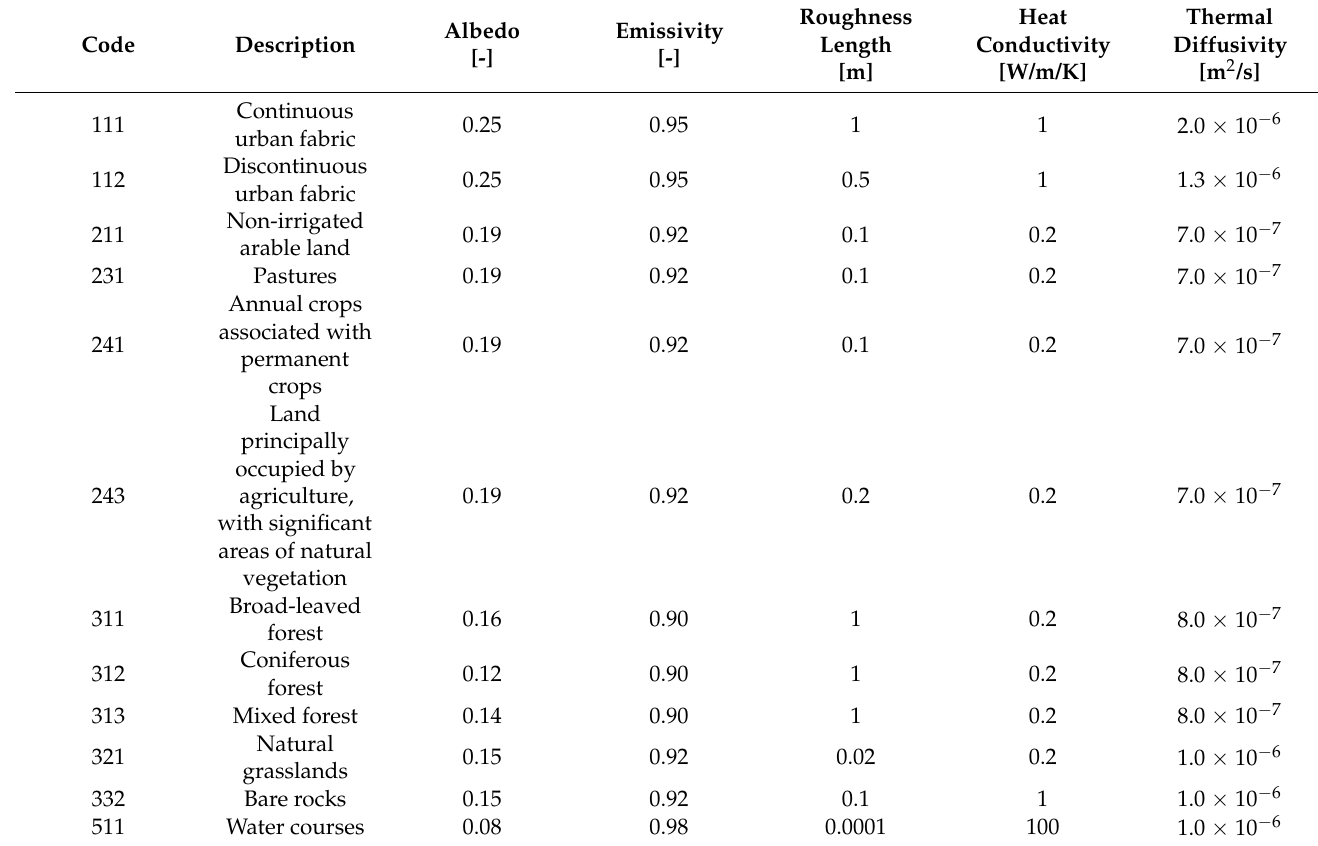
Table 1. Land-use characteristics used in the Graz Mesoscale Model-Scientific (GRAMM-SCI) based on CORINE land- use